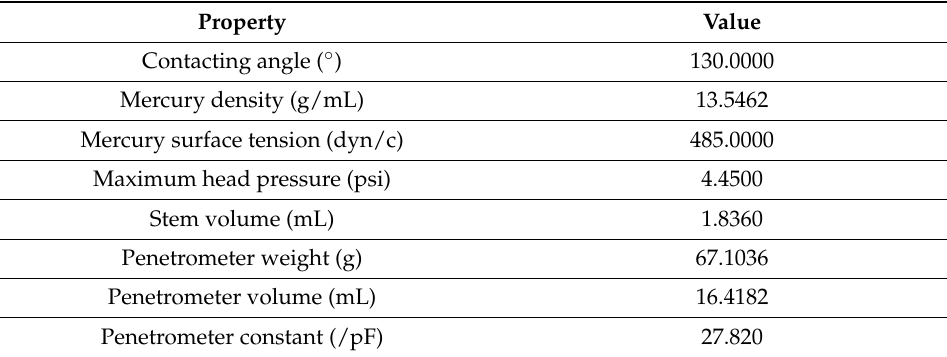
Table 6. Mercury intrusion porosimetry conditions.